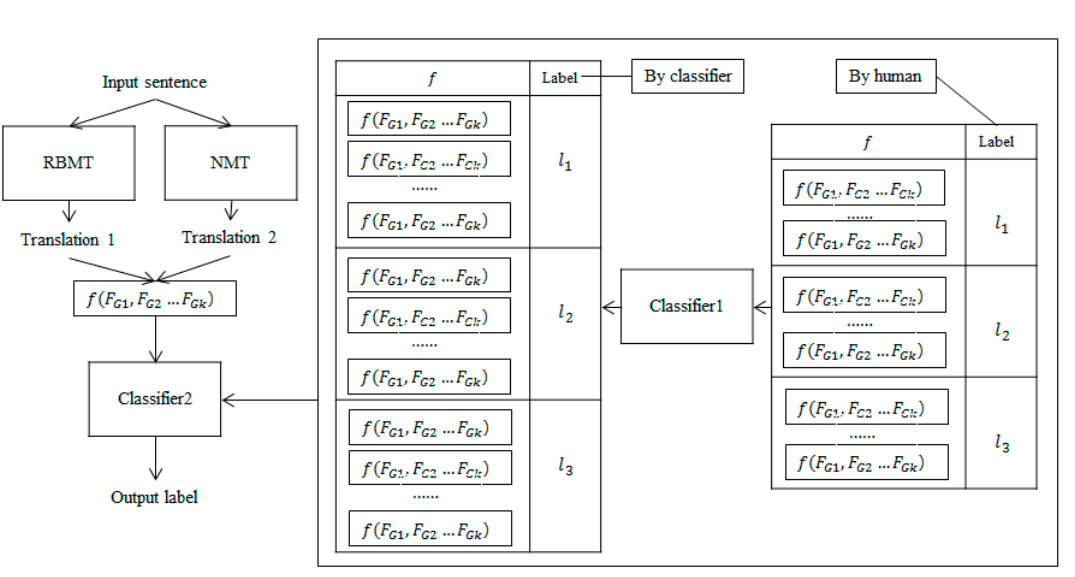
Figure 1. Hybrid system architecture. Classifier 1 is trained on the human-labeled dataset to automatically build a larger dataset. The automatically classified dataset is used with the human-labeled data to train the Classifier 2 for hybrid translation.